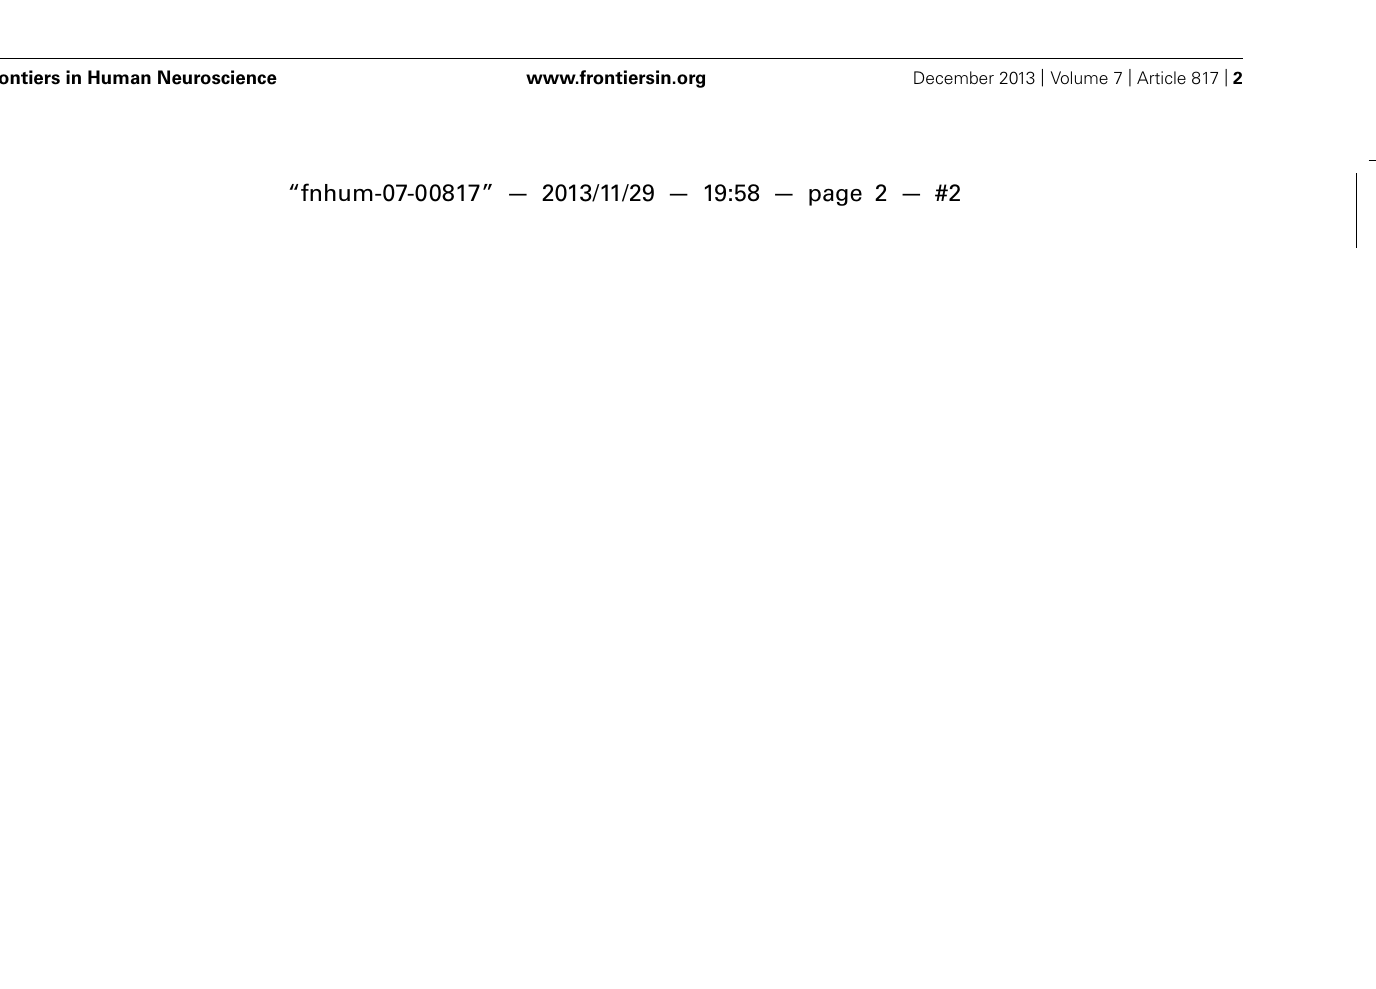
(D) on the FA maps using a general linear model. Fiber tracts are reconstructed for the complete brain (C) and, for each tract, the t -values found in the SPM along that tract were grouped into a single set of t -values (E) . For each tract a statistical test (student’s t -test) is done (F) on the set of t -values to test if the average t -value found along the tract is significantly ( t > 5) greater then